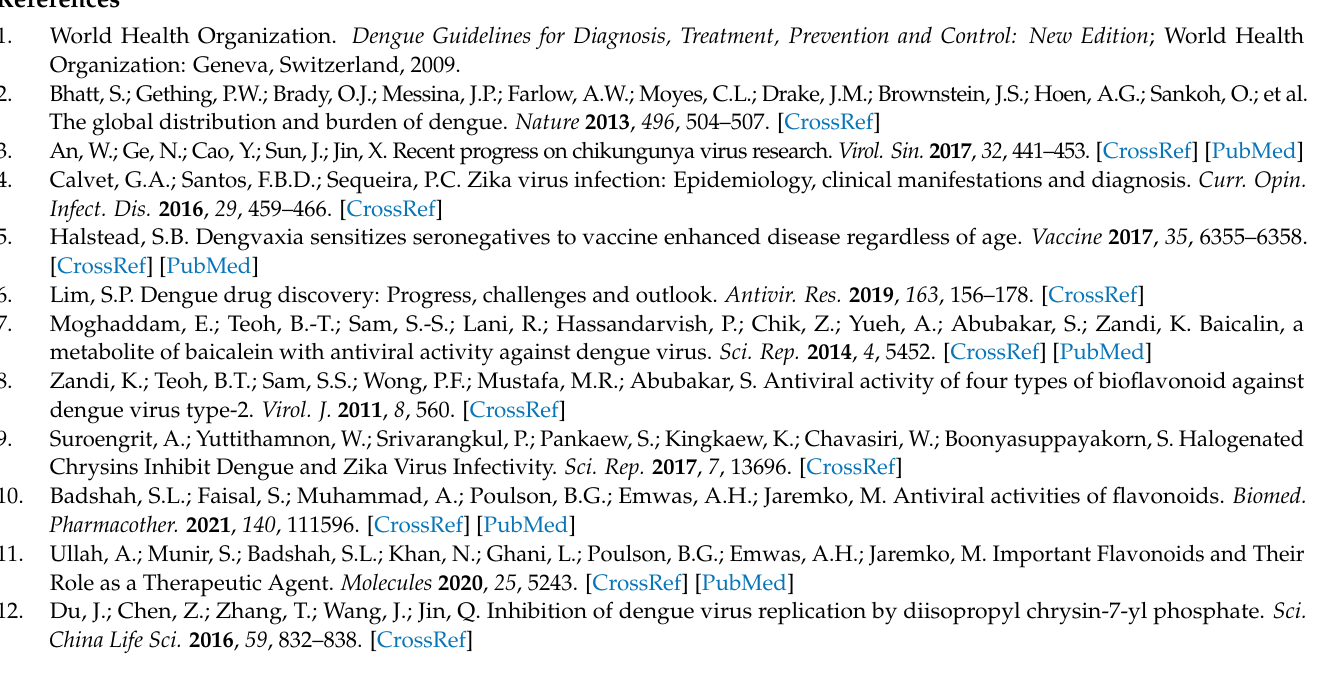
Supplementary Materials: Table S1: list of top 10 proteins related to apigenin and their subcellular distribution, Figure S1: A, structure overlay of estradiol and apigenins; B,C, the 3D structure